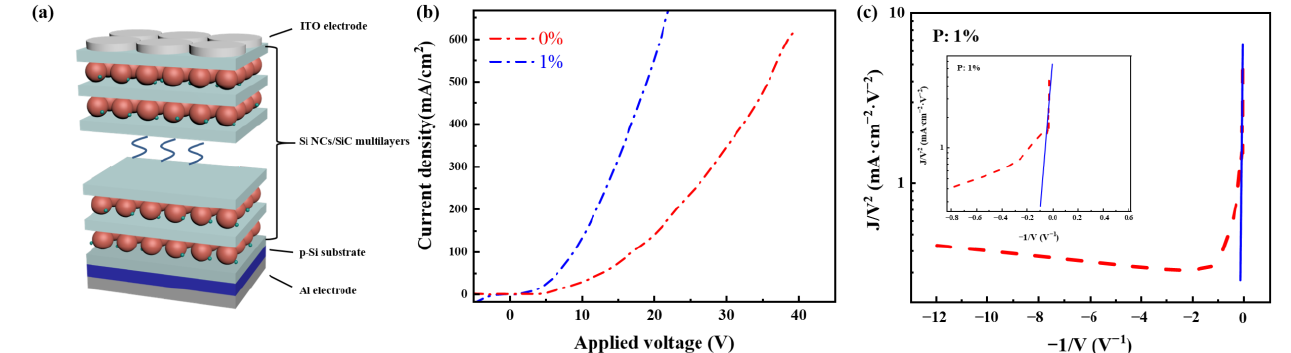
Figure 4. ( a ) Schematic structure of the Si NCs/SiC multilayer LED fabricated in this work; ( b ) current density of 0% and 1% P-doped LEDs as a function of applied voltage; ( c ) FN tunneling plot of 1% P-doped data; inset is the zoom of the region fitting the FN mechanism.